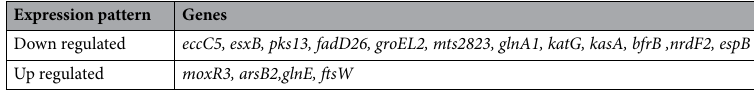
Table 3. Genes selected for validation.